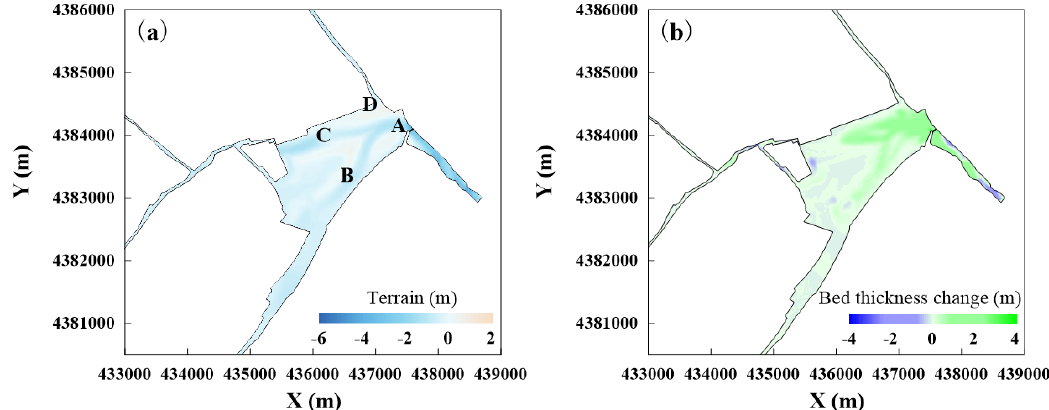
Figure 14. ( a ) Bathymetric map on 1 January 2008; ( b ) bed thickness change for the QL system from 1990 to 2007.